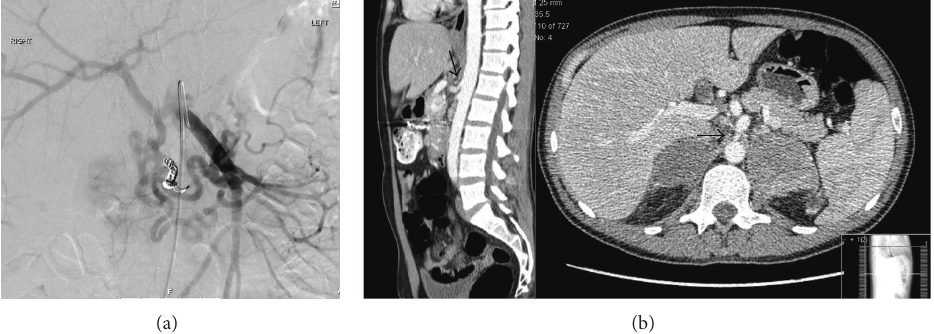
Figure 1: (a) Selective catheterization of SMA, showing hypertrophic inferior pancreatoduodenal arteries supplying through the GDA the proper hepatic artery and right and left hepatic arteries. Coils in posterior inferior pancreaticoduodenal artery. (b) CT scan (arterial phase). Stenosis at the origin of the celiac artery with poststenotic dilatation (arrows). Cross-sectional images illustrated the sizeable bilateral adrenal